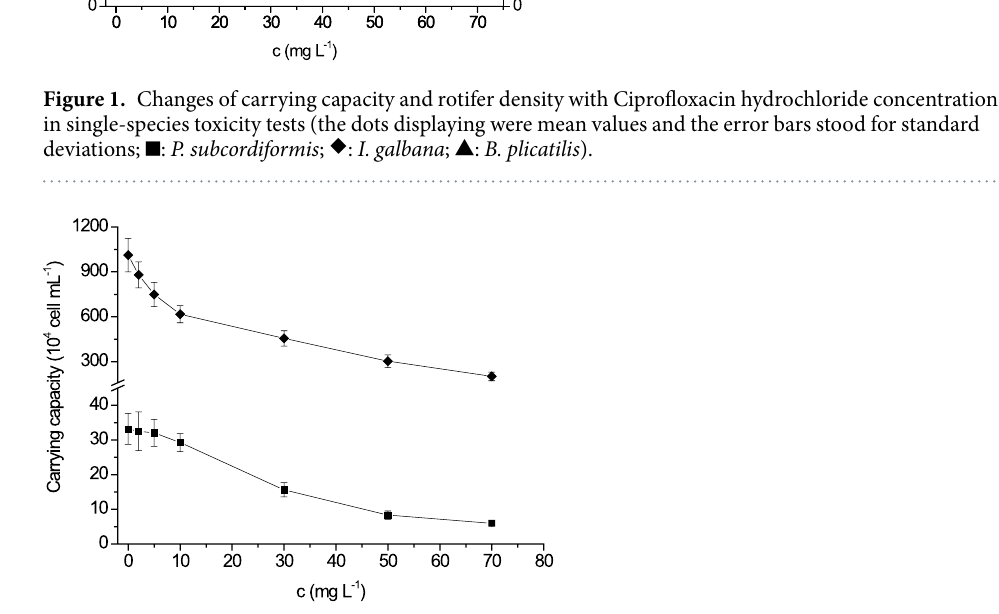
Figure 2. Changes of carrying capacity with Ciprofloxacin hydrochloride concentration in algae bi-species toxicity tests (the dots displaying were mean values and the error bars stood for standard deviations; ■ : P. ◆ subcordiformis ; : I. galbana ).